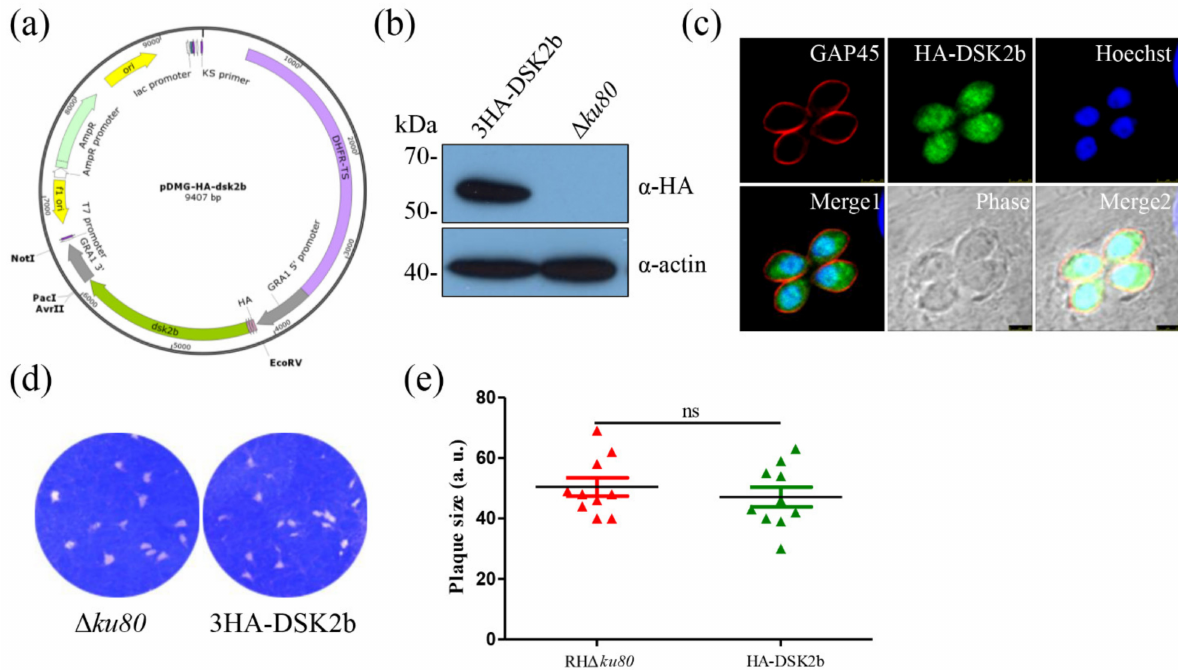
Figure 2. DSK2b is localized in the cytoplasm and nucleus of T. gondii . ( a ) Map of the pDMG-HA-DSK2b plasmid. The expression of HA-DSK2b was under the control of the T. gondii GRA1 promoter. ( b ) Western blotting identified the expression of HA-DSK2b. Lysates of the parasite were probed with anti-HA monoclonal antibody (upper panel). Actin served as the loading control (bottom panel). ( c ) Immunofluorescence assays determined the localization of HA-DSK2b. Parasites were labeled with mouse anti-HA monoclonal antibody (green) and rabbit anti-TgGAP45 (red). Hoechst was used to stain the nuclei (blue). Scale bar: 2.5 µ m. ( d , e ) Plaque assay of the HA-DSK2b overexpression strain. A total of 500 tachyzoites were inoculated in HFFs for 7 days and then stained with crystal violet ( d ). Quantification of plaque sizes ( e ). 10 plaques were quantified; ns: not